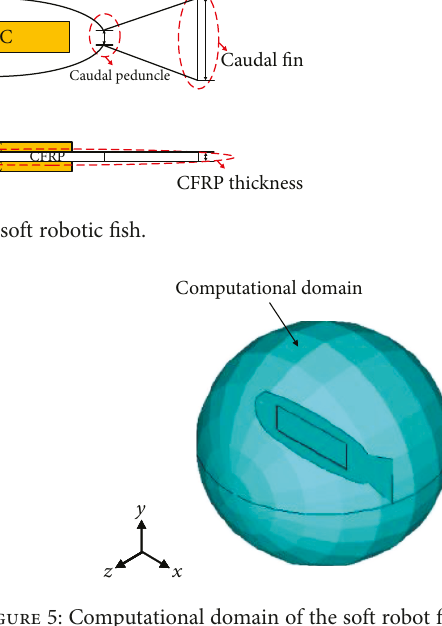
Figure 5: Computational domain of the soft robot fi sh in the fl